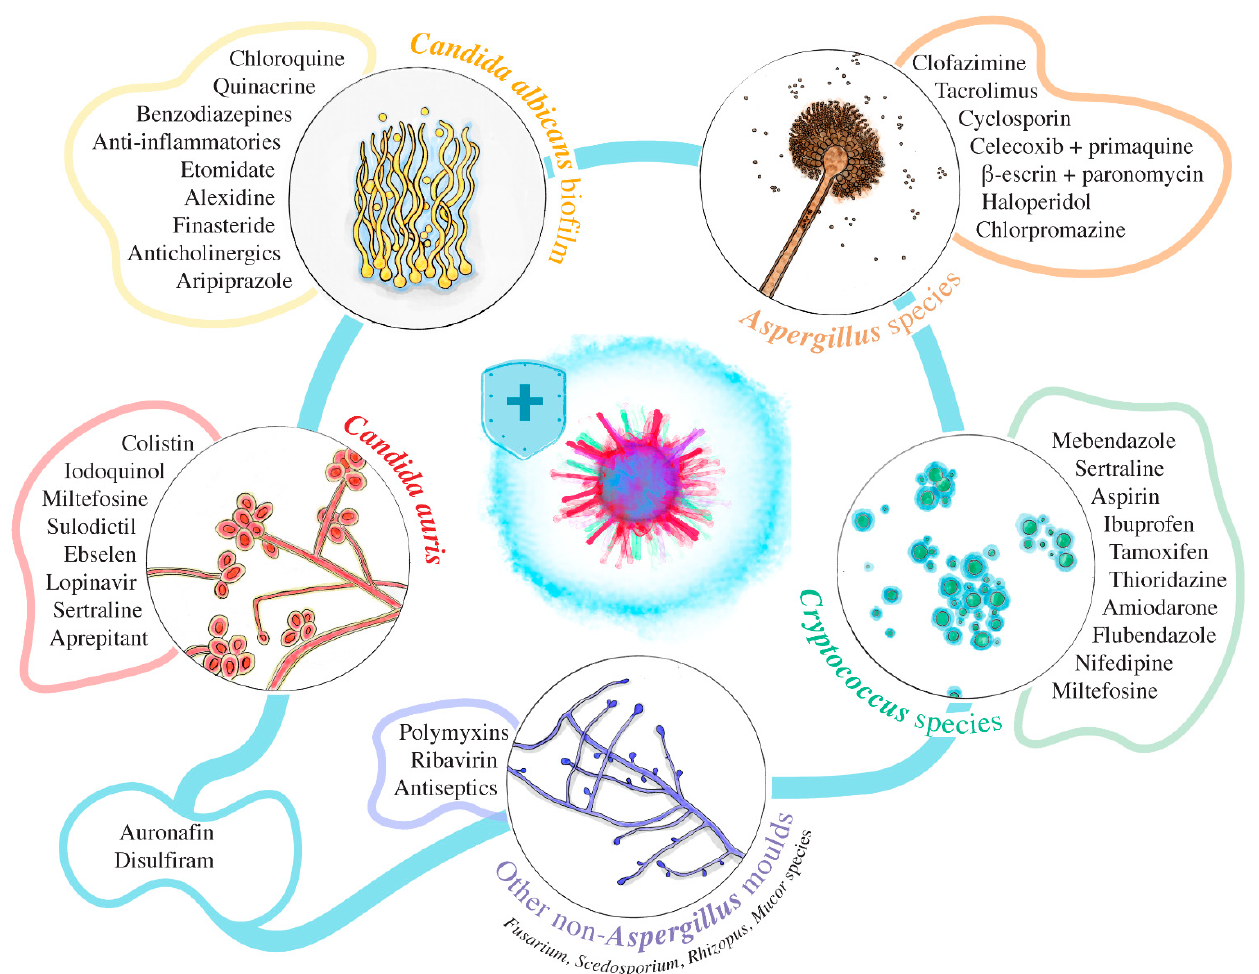
Figure 2. Examples of approved and candidate drugs with activity against emerging MDR fungi .